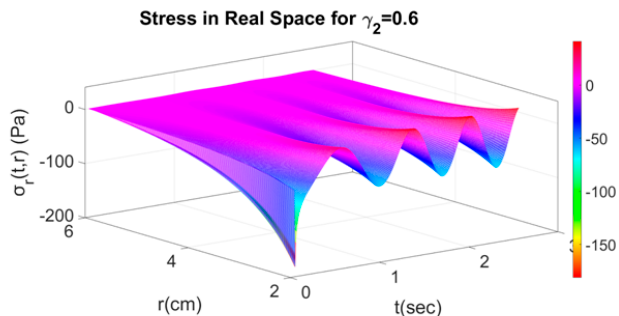
( t , r ) in the initial space for γ = 0.8. θ